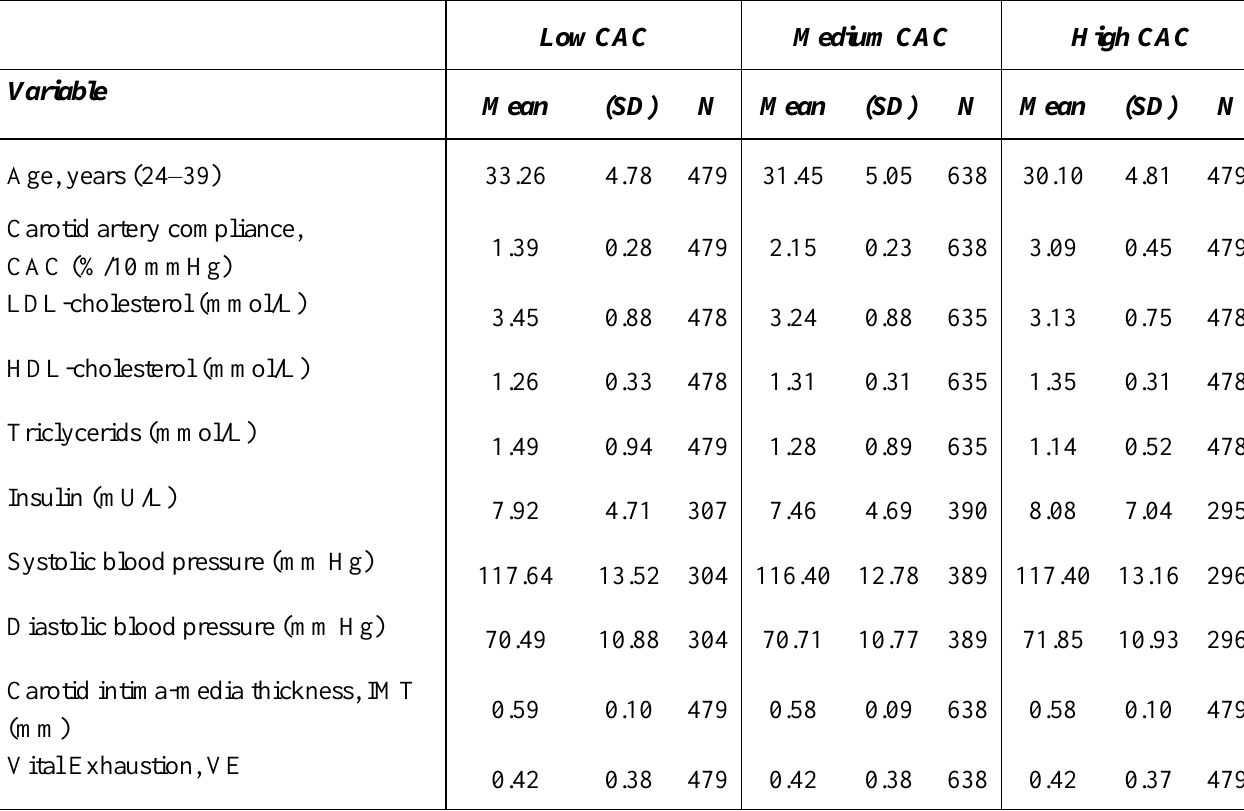
Table 3. Study characteristics in subgroups stratified by CAC